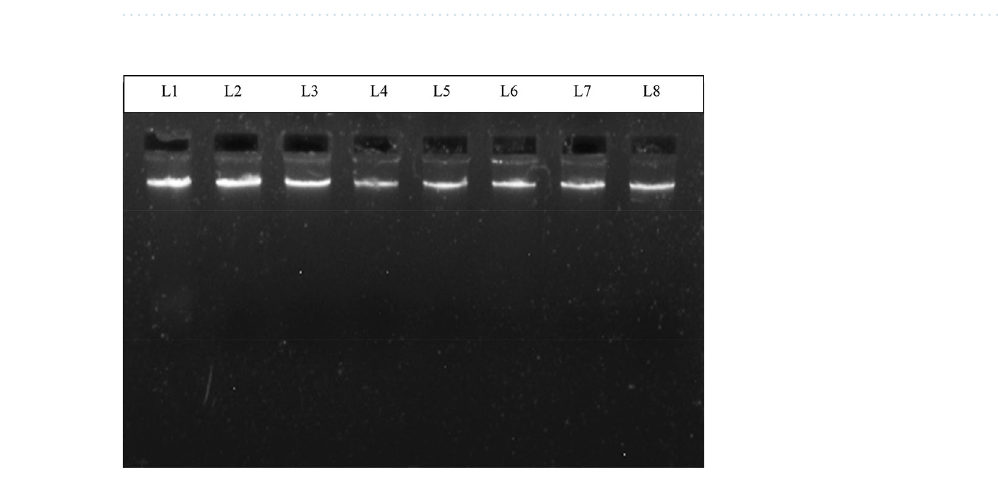
Figure 1. Representative picture of the genomic DNA run on 1% agarose